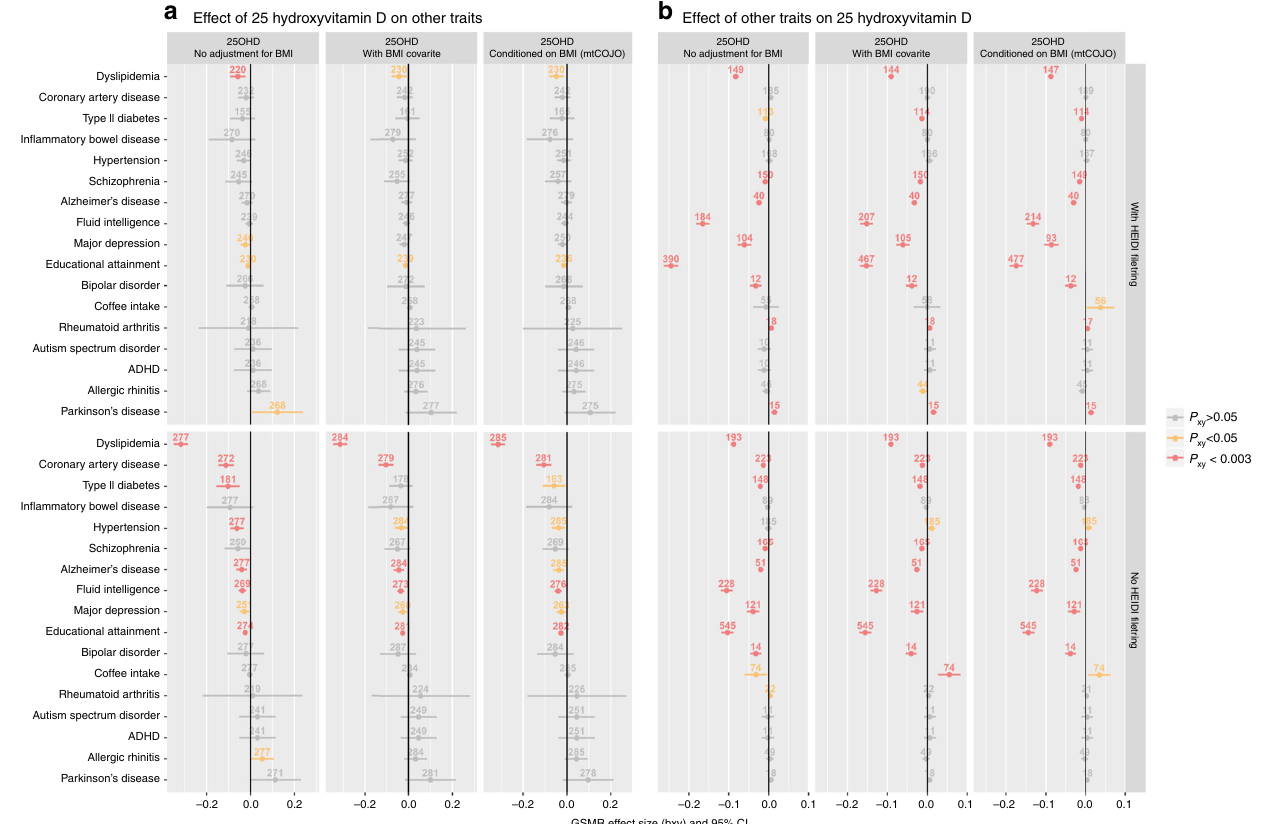
Fig. 5 Mendelian randomisation analysis estimates from GWAS results from 25OHD and selected phenotypes. Bidirectional Generalised Summary-data level Mendelian Randomisation (GSMR) between 25-hydroxyvitamin D (25OHD) concentrations and selected phenotypes, by three types of adjustments for body mass index (BMI) and with/without HEIDI fi ltering of pleiotropic loci. Panel a shows the estimate of the causal effect estimate ( ^ b xy ; dots), and 95% con fi dence intervals (bars), of 25OHD concentration on selected phenotypes. ^ b xy (and respective P -values) was obtained with the generalised summary-data-based Mendelian randomisation (GSMR) method 16 . Negative ^ b xy indicates that variants associated with increased 25OHD concentration were associated with a smaller value/reduced risk for the phenotypes of interest. Panel b shows the estimate of the causal effect (and 95% con fi dence intervals) of the same selected phenotypes on 25OHD concentration. Results are presented with (upper half) and without (lower half) fi ltering of pleiotropic associations with the heterogeneity in dependent instruments (HEIDI) test, respectively. The numbers above each effect size indicate the number of SNP instruments used in each analysis. For each set of analyses, we show GWAS results: (i) without adjustment for body mass index (BMI), (ii) with BMI included as a covariate and (iii) conditioned on BMI using mtCOJO 16 . The GMSR estimates and 95% con fi dence intervals are shown in three colours according to the P -value thresholds: grey (non-signi fi cant; PGSMR > 0.05), yellow (nominally signi fi cant; PGSMR < 0.05) and red (signi fi cant after Bonferonni correction for multiple testing; PGSMR < 0.003). All ^ b xy , respective standard errors and P -values can be found in tabular form in